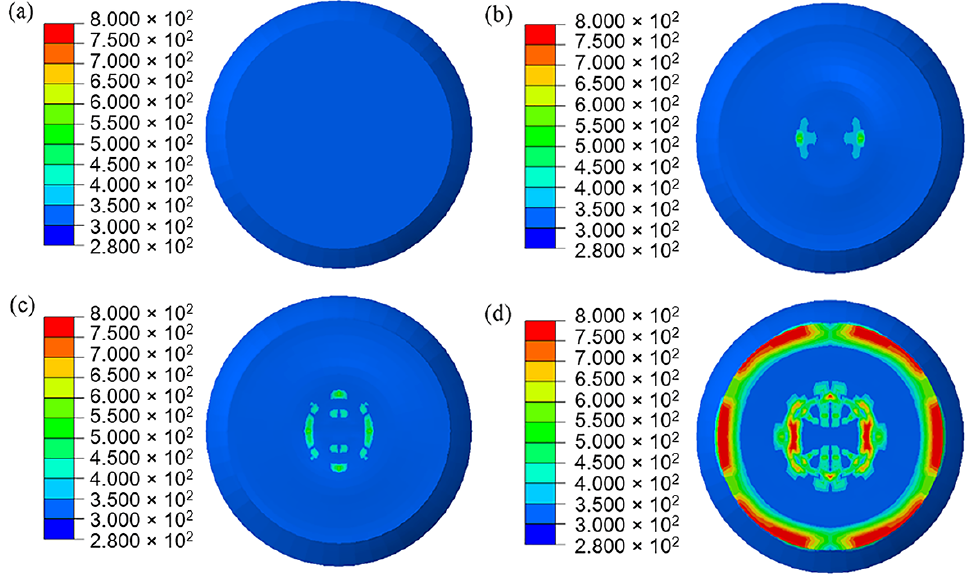
Figure 16. Evolution of the microcrack surface temperature of the PBX1314 main explosive. ( a ) 500 μ s. ( b ) 1300 μ s. ( c ) 2300 μ s. ( d ) 3300 μ s.